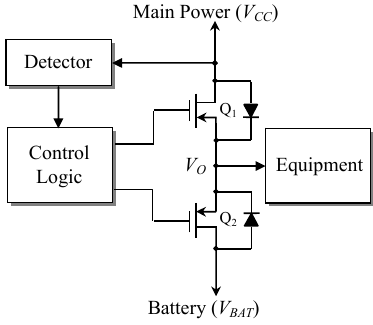
Figure 2. Switching control architecture using main power detection.